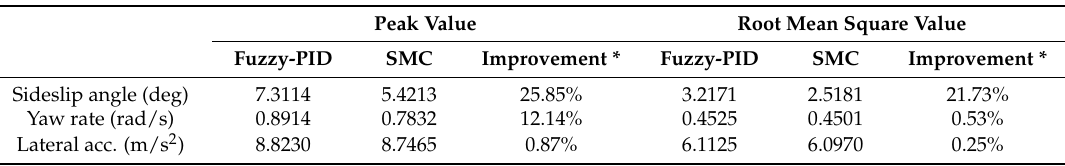
Table 4. Improvements in peak values and RMS values.